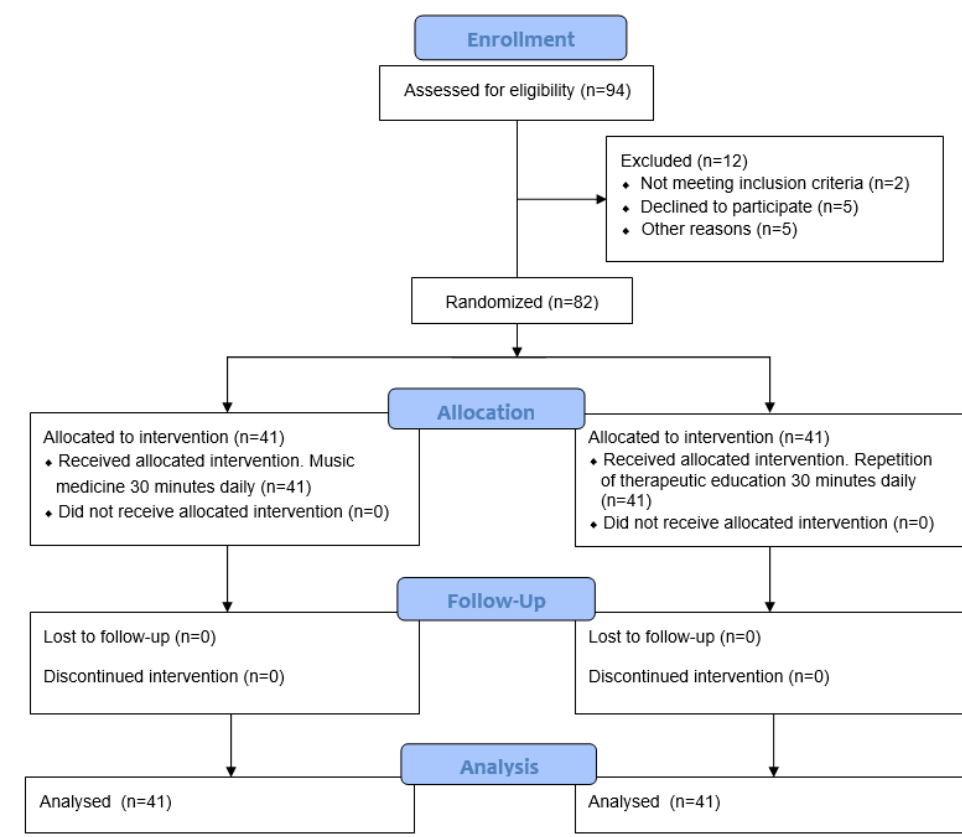
Figure 1. Flow chart for recruitment and procedures of the study.